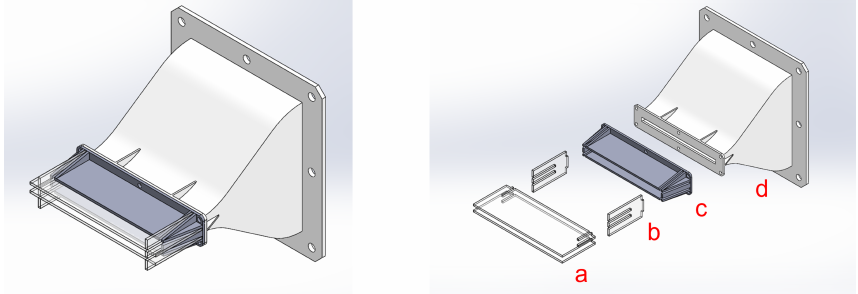
Figure 7. 3D design of rectangular nozzle (7.5 mm × 150 mm) AR = 20 assembly with plasma actua- tors. Parts (a), (b), (c), and (d) to construct the assembly are indicated in the right-side exploded view.